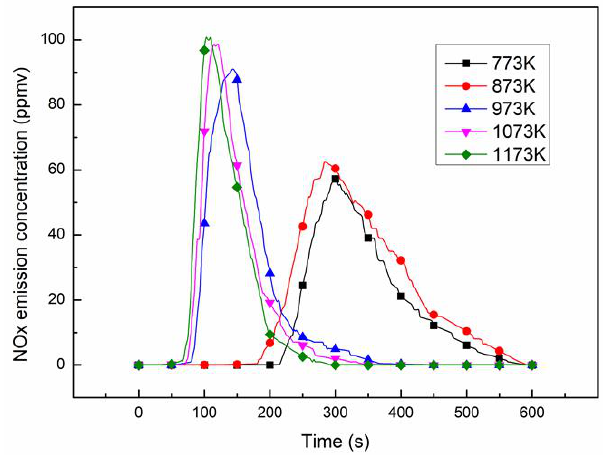
Figure 6. The e ff ect of combustion temperature on NO X emission concentration. Figure 6. The effect of combustion temperature on NO X emission concentration. Figure 6. The effect of combustion temperature on NO X emission concentration.